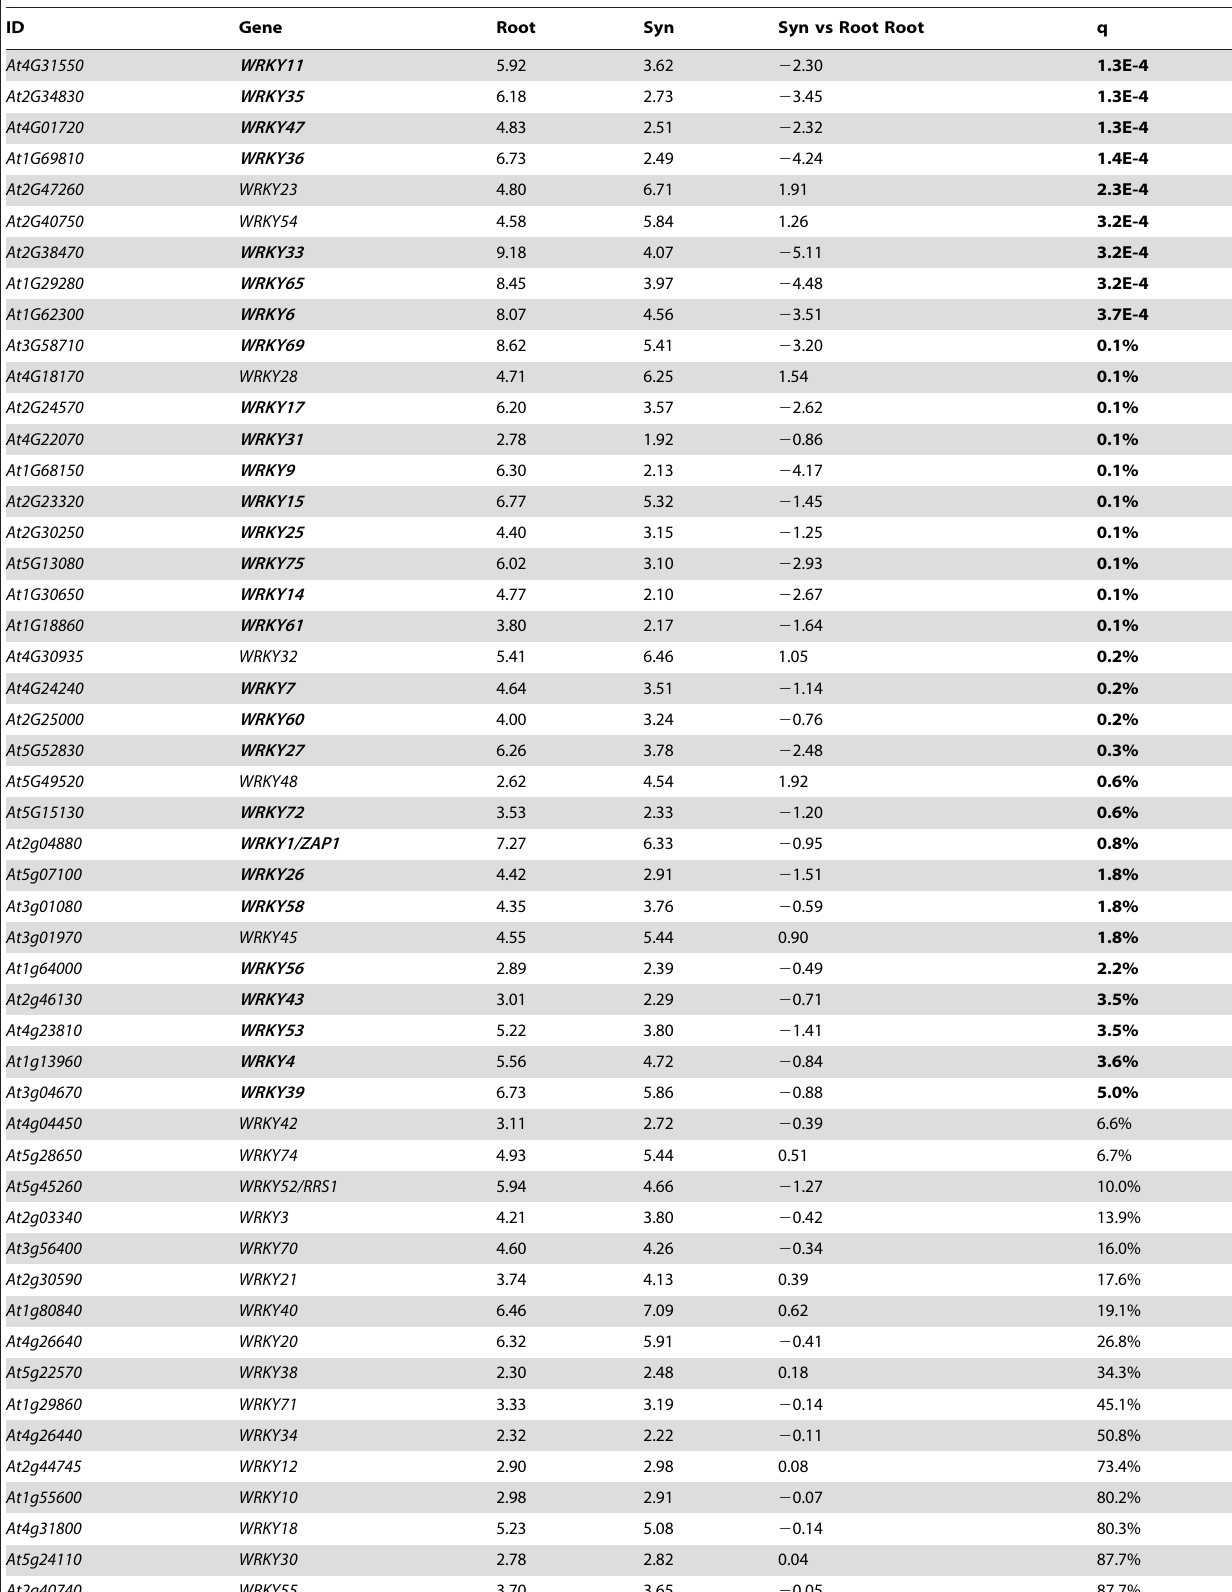
Table 1. Expression of WRKY genes in syncytia and control root segments.